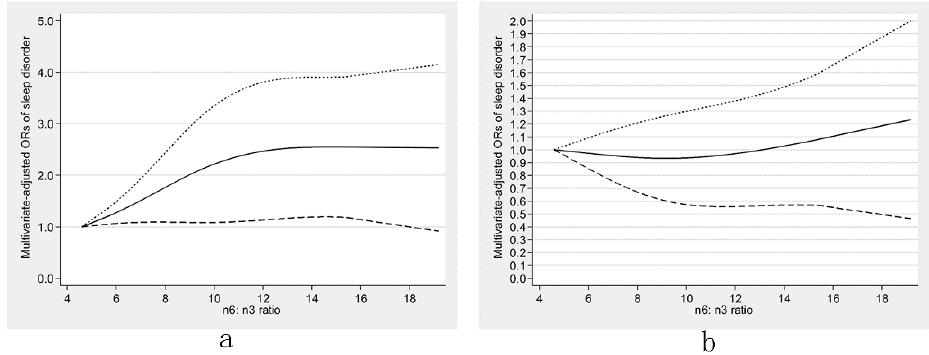
Figure 5. Restricted cubic spline models of the odds ratios (ORs) of sleep disorders with dietary ω-